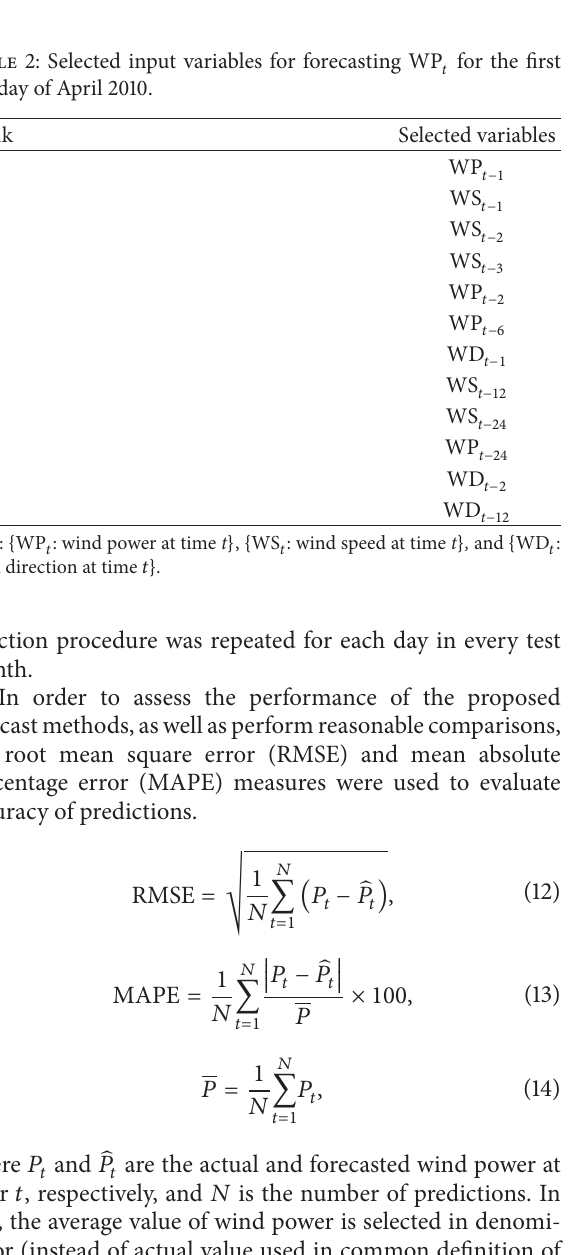
Figure 4: Procedure of MI-based input variable selection.